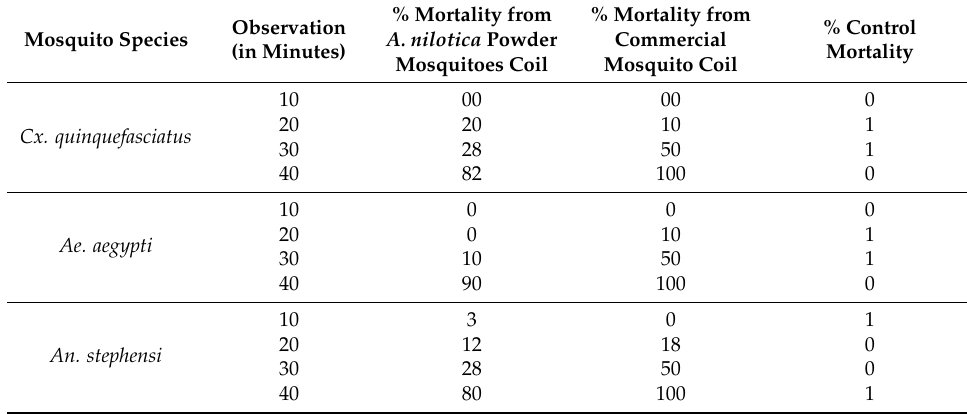
Table 4. Smoke toxicity of A . nilotica plant seeds powder mosquito coil compared with commercial mosquito coil and mosquito coil without any plant powder on major mosquito